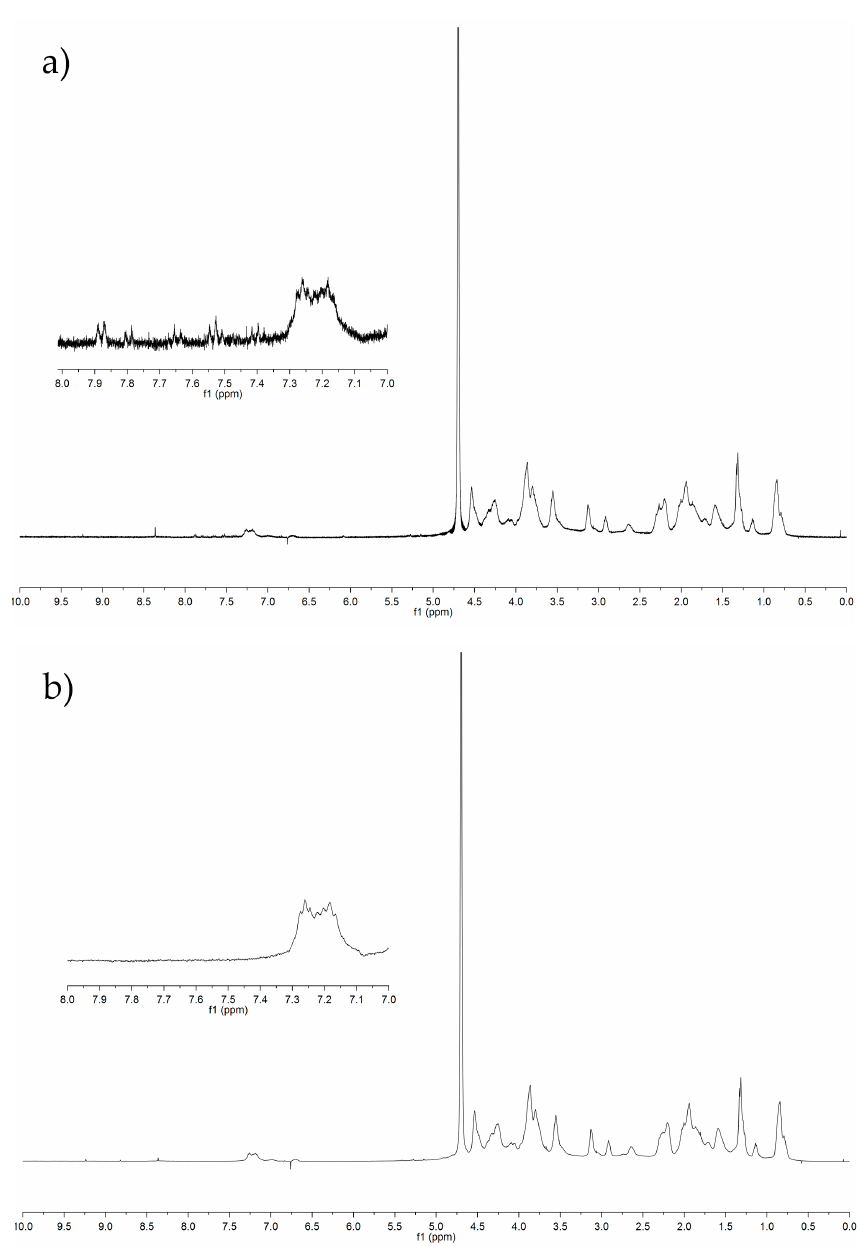
Figure 5. 1 H NMR (400 MHz, D 2 O) of gelatin treated with 5, 5 µmol ( a ) compared to untreated gelatin ( b ).